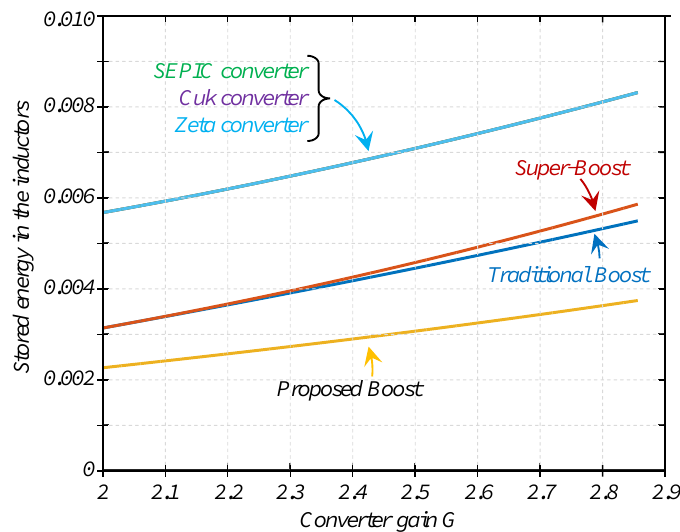
Figure 18. Stored energy in inductors for all topologies in the full operation range vs. the converter gain G. The best performance is observed on the proposed ISB converter, achieving the desired input current ripple with the smallest stored energy in